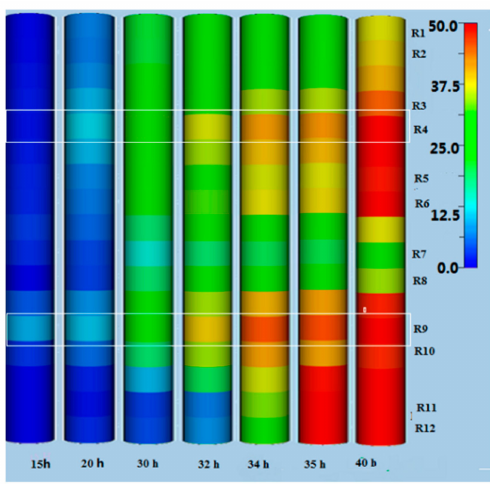
Figure 8. Hydrate-saturation distribution in sediments at di ff erent